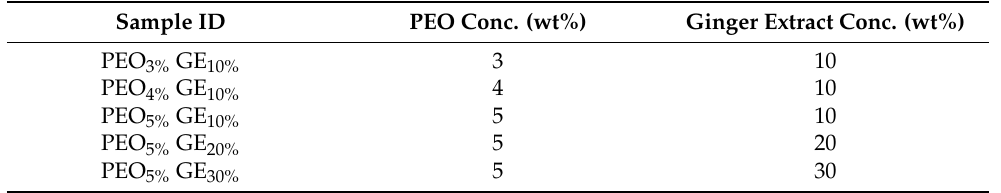
Table 2. Sample ID description.